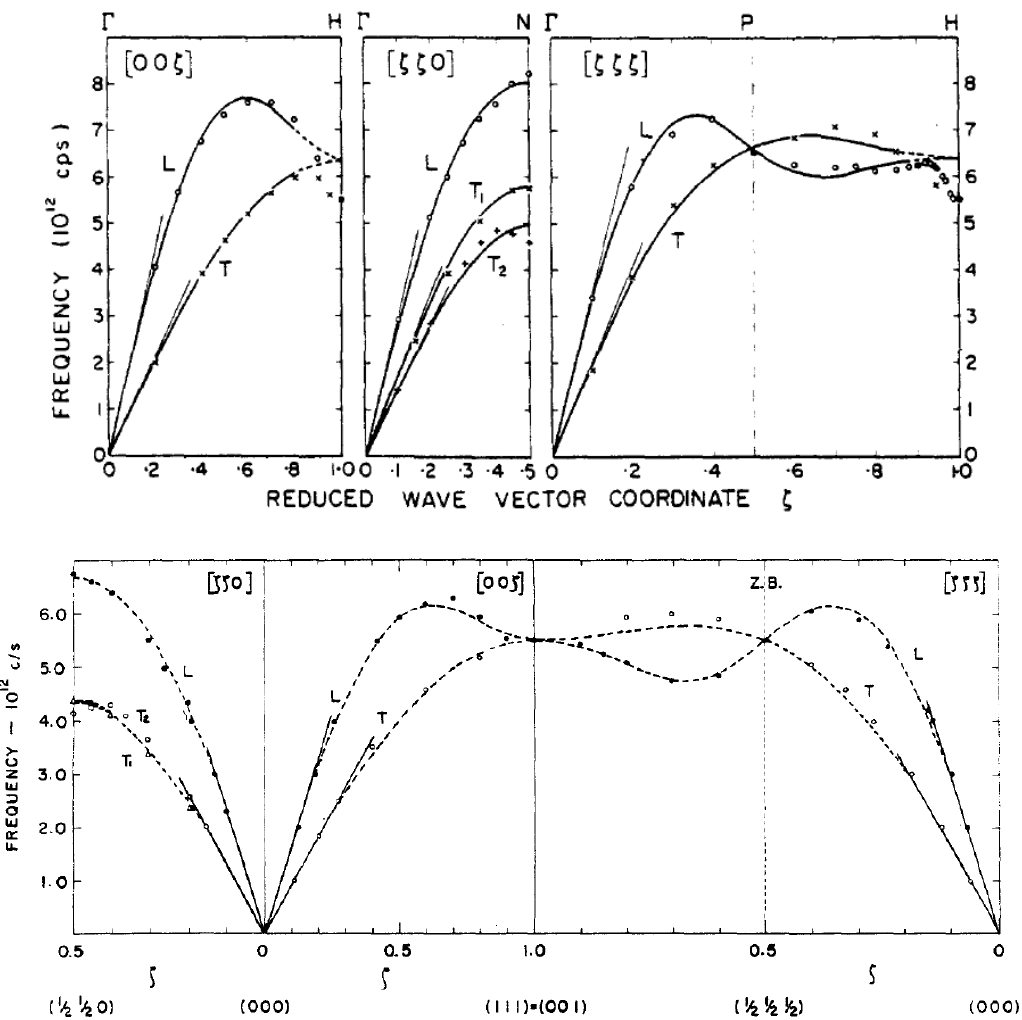
Figure 31. The upper figure shows the phonon dispersion relations in molybdenum at 296 K. The straight lines through q = 0 were determined from the measured elastic constants. The solid curves are the results of the best fit to the third neighbor axially symmetric force model. The model was not fitted to the region of the broken curves near the position H in the Brillouin zone, which is a Kohn anomaly. The lower figure shows similar measurements on tungsten at 296 K, which indicate no obvious Kohn anomalies. The upper figure is taken from Figure 1 of ref. [81] and the lower is taken from Figure 1 of ref. [83]. Copyright by the American Physical